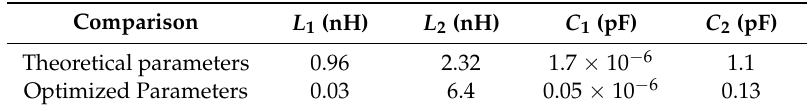
Table 1. Comparison of the equivalent circuit model parameters for the simulation (ADS) and theoretical bandpass filter.